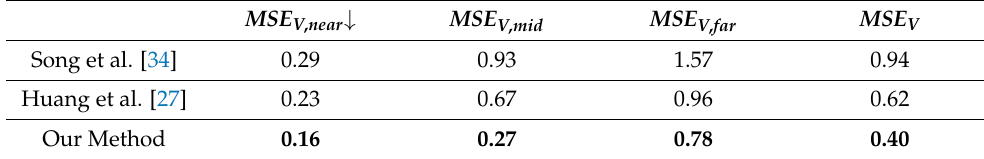
Table 6. Quantitative results of speed estimation for the KITTI